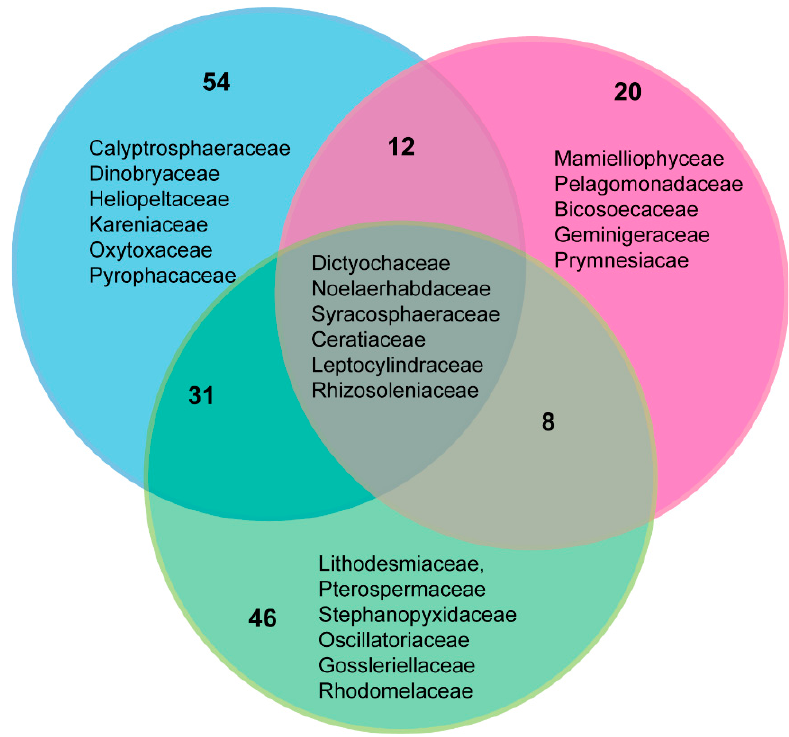
Figure 9. Venn-diagram showing the overlap in taxa observed in the Western Channel in 2011–2012 WaMS (pink), CPR microscopy (Green) and WCO L4 microscopy (Blue). Examples of taxa observed in each sector are also listed but not exhaustive.